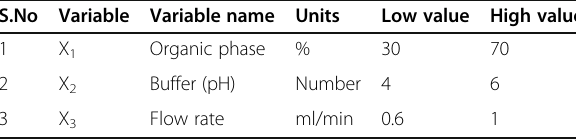
Table 1 Variables for optimization with its upper and lower values